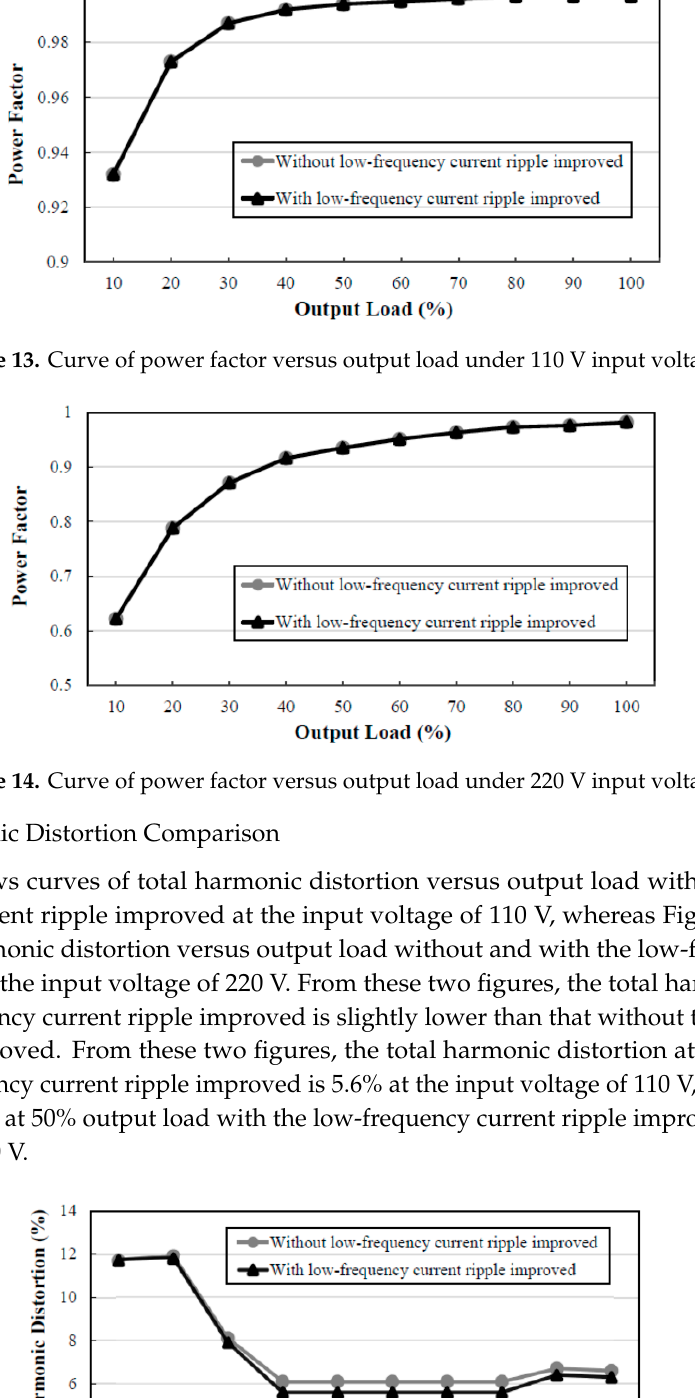
Figure 16. Curve of total harmonic distortion versus output load under 220 V input voltage. 5.4.4. Output Current Ripple Comparison Figure 17 shows curves of output current ripple versus output load without and with the low- frequency current ripple improved at the input voltage of 110 V, whereas Figure 18 shows curves of output current ripple versus output load without and with the low-frequency current ripple improved at the input voltage of 220 V. Figure 17. Curve of output current ripple versus output load under 110 V input voltage.